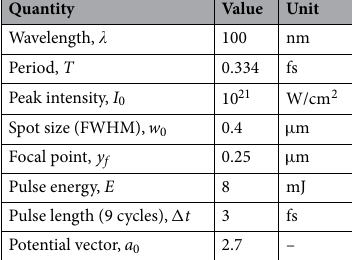
Table 2. Laser parameters.